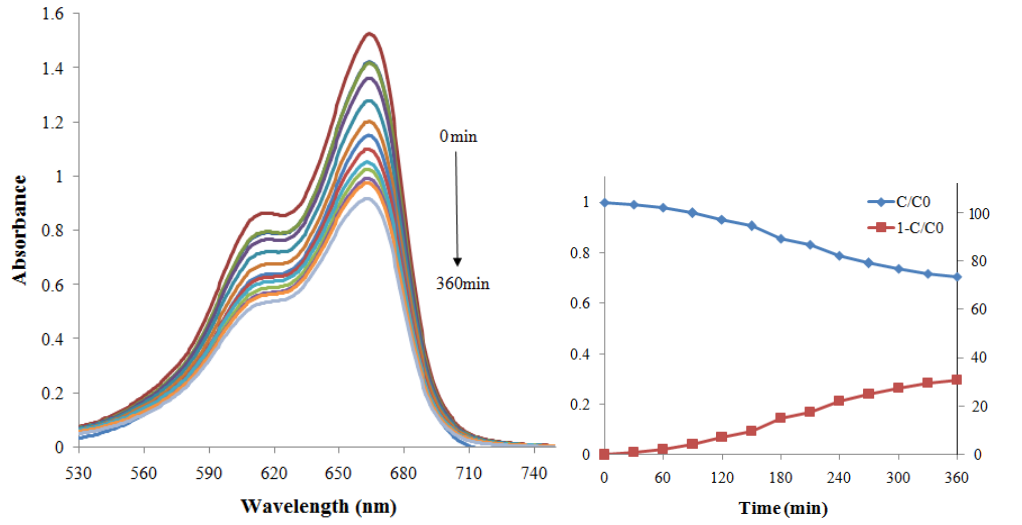
Figure 7. Absorption spectral changes and photodegradation of methylene blue (MB) aqueous solution degraded by ZnS nanoparticles under visible